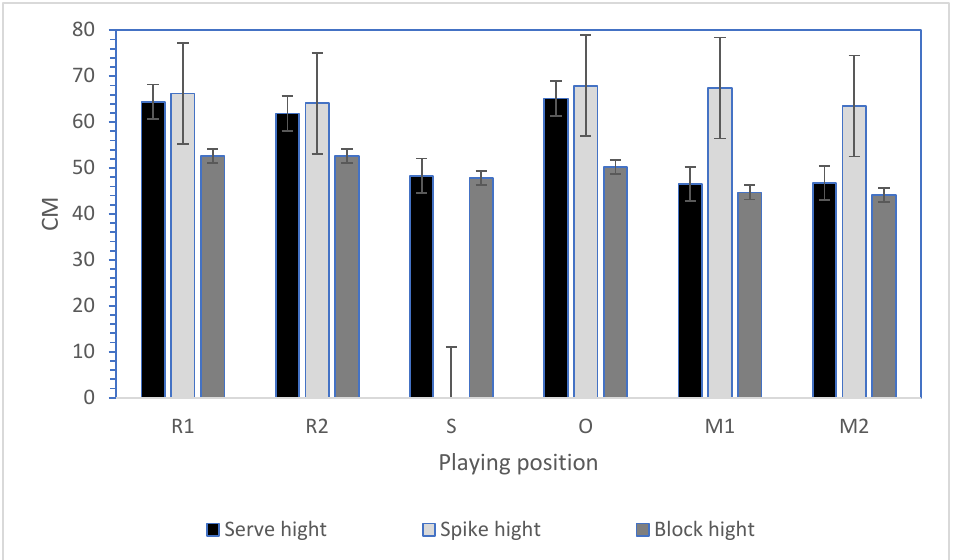
Figure 4. The results of the comparison between jump flying distance (JFD) and serve, attack, and block for the players at given positions (R1, R2—Receiver; S—Setter; O—Opposite; M1, M2—Middle blocker). The results of the comparison between JFD and serve, attack, and block for the players at given